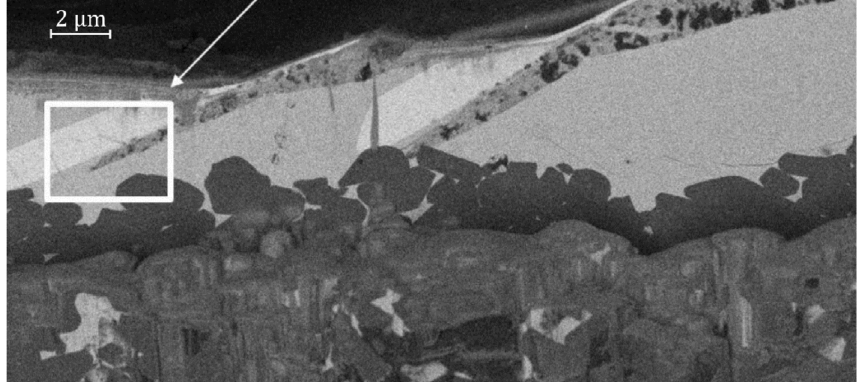
Fig. 4. SEM cross section picture of the same paste as before but on an alumina substrate, RTP fi red at a peak temperature of 700 ° C. No Te formation is visible, but large Bi-rich crystals, marked by the white rectangle and